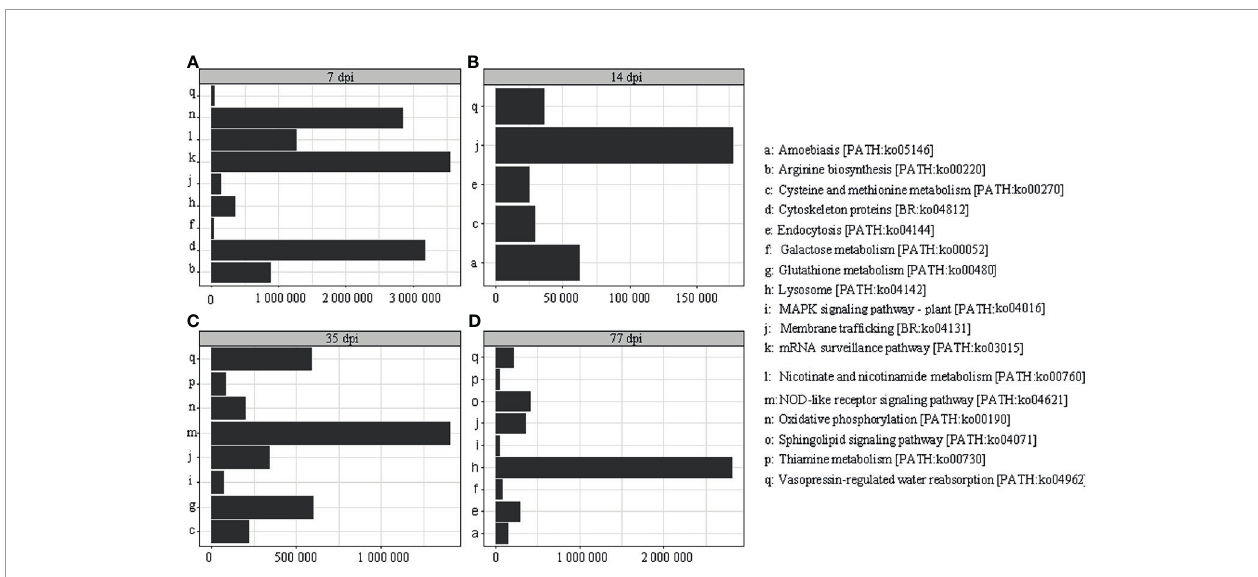
FIGURE 4 | Kyoto Encyclopedia of Genes and Genomes (KEGG) analysis of the different periods after infection; the different periods are displayed on the horizontal axis and the abundance expressed by speci fi c proteins is displayed on the longitudinal axis. (A) KEGG analysis of proteins at 7 dpi with C. sinensis . (B) KEGG analysis of proteins at 14 dpi with C. sinensis . (C) KEGG analysis of proteins at 35 dpi with C. sinensis . (D) KEGG analysis of proteins at 77 dpi with C. sinensis